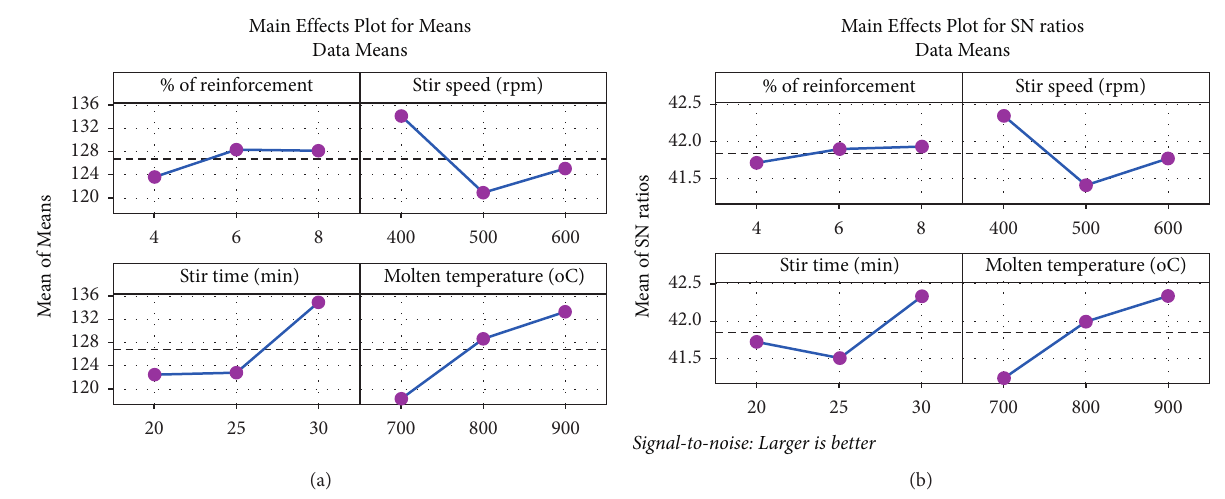
Figure 5: Contour plot for wear test: (a) % of reinforcement Vs stir speed, (b) stir speed Vs stir time, (c) stir time Vs molten temperature, and (d) molten temperature Vs % of